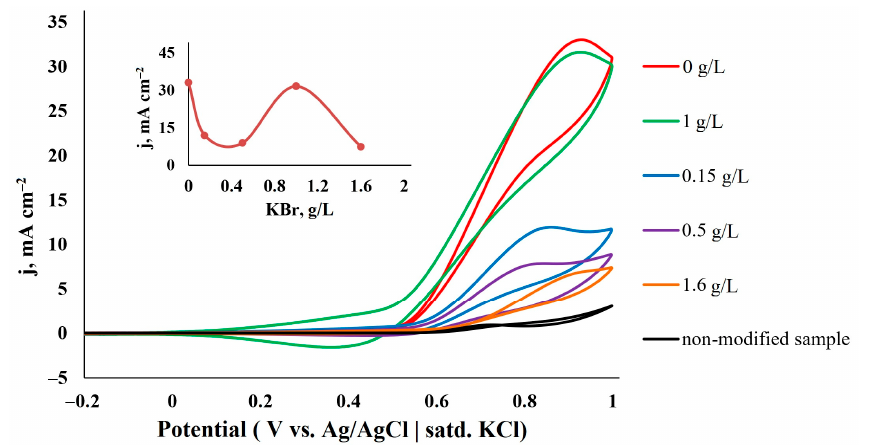
Figure 9. Cyclic voltammograms of copper catalysts obtained at various KBr concentrations in the working solution. Inset: plot of anodic peak current versus structurant concentration (KBr) during copper deposition.